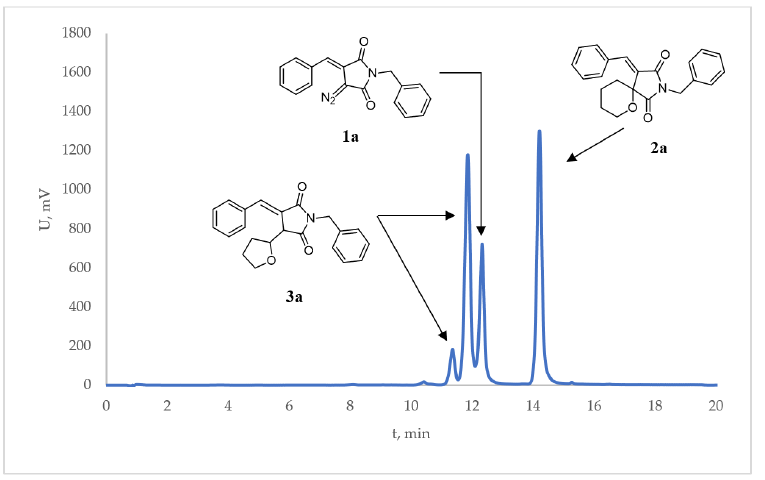
Figure 1. Typical HPLC chromatogram of a mixture consisting of 1a , 2a, and 3a components ( 3a was formed as a mixture of diastereomers).